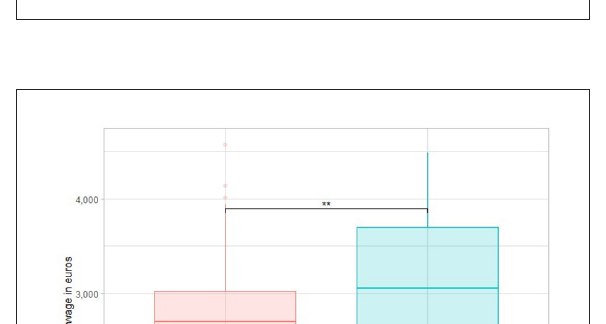
FIGURE1 Wage distribution according to gender.